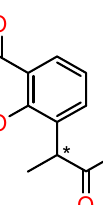
10 Figure 9. The structures of chiral baicalin derivatives formed from baicalin and phenylalanine me- thyl esters-BAL ( 9 ) and BAD ( 10 ). 4.3. Chiral Derivatives of Ricinoleic Acid ( R )-(Z)-ricinoleic acid (RA) ( 11 – 12 ) is a natural fatty acid and is the main component of castor oil from Ricinus communis L., seeds. Many synthetic derivatives of RA with inter- esting biological activities have been obtained [85]. In particular, amides, esters, and gly- cosides exhibited potent antiproliferative and cytotoxic activities [86,87]. The modification of the parent compounds by amines resulted in increased cytotox- icity of the obtained products against HT29, HCT116, MCF-7, and AGS cancer cells (hu- man colorectal adenocarcinoma cell line, human colorectal carcinoma cell line, human breast adenocarcinoma cell line, and human gastric adenocarcinoma cell line, respec- tively). The antitumour effect was observed for both enantiomeric forms. The most